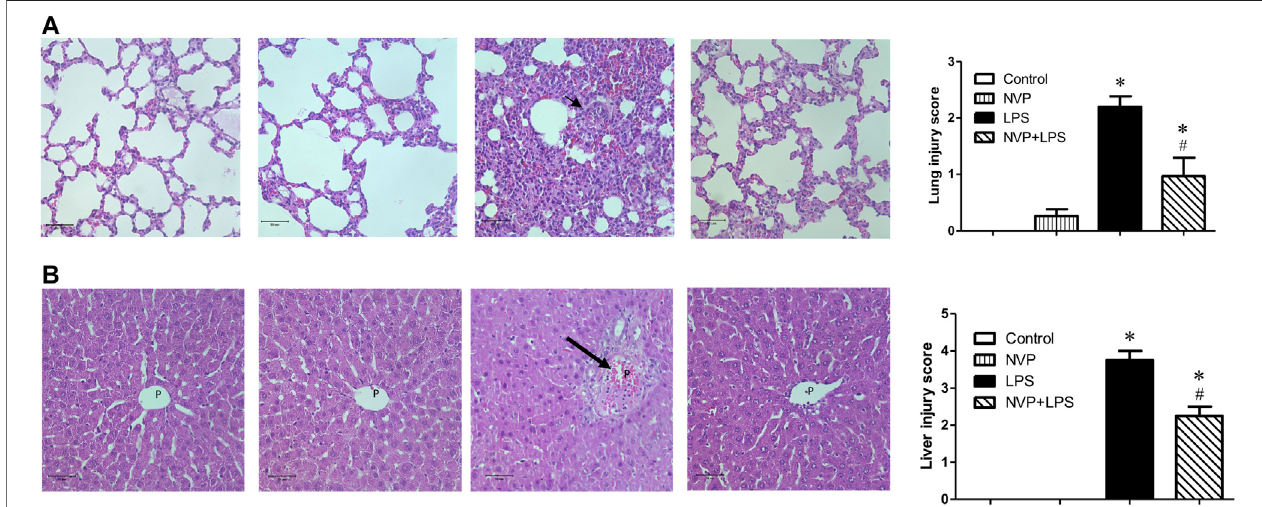
FIGURE 6 | Effects of NVP-AUY922 pretreatment on histology of lung(A) and liver(B) sections. Sections were stained with hematoxylin and eosin, each × 400 (original magni fi cation). Panels from left to right were control, NVP, LPS and NVP+LPS group, respectively. Short arrow in (A) indicates in fi ltration of the in fl ammatory cells. Longarrowin (B) indicatesdegenerationand necrosisofthehepatocytes.P,portalveinspace.Scalebar:50 μ m.Valuesareexpressed asmean ± SEM.* p < 0.05 vs. Control group, # p < 0.05 vs. LPS group.